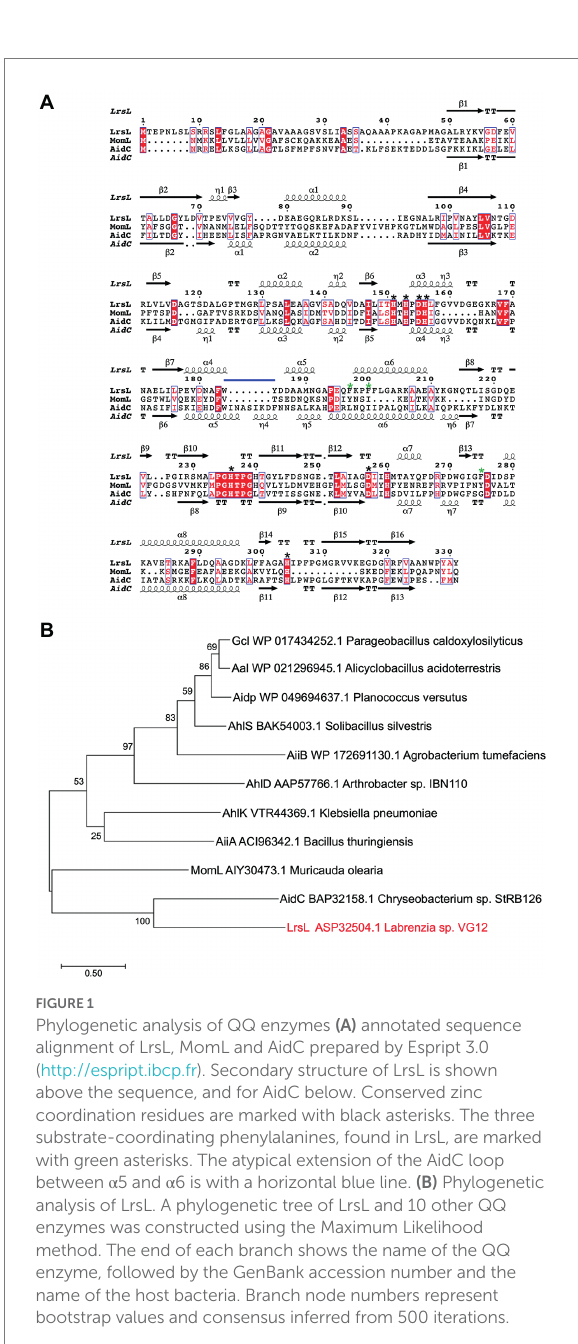
FIGURE 1 Phylogenetic analysis of QQ enzymes (A) annotated sequence alignment of LrsL, MomL and AidC prepared by Espript 3.0 (http://espript.ibcp.fr). Secondary structure of LrsL is shown above the sequence, and for AidC below. Conserved zinc coordination residues are marked with black asterisks. The three substrate-coordinating phenylalanines, found in LrsL, are marked with green asterisks. The atypical extension of the AidC loop between α 5 and α 6 is with a horizontal blue line. (B) Phylogenetic analysis of LrsL. A phylogenetic tree of LrsL and 10 other QQ enzymes was constructed using the Maximum Likelihood method. The end of each branch shows the name of the QQ enzyme, followed by the GenBank accession number and the name of the host bacteria. Branch node numbers represent bootstrap values and consensus inferred from 500